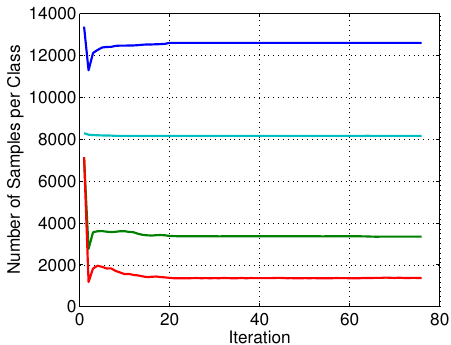
(a) Number of samples per class (class is colour coded) of training set T02 for each iteration.